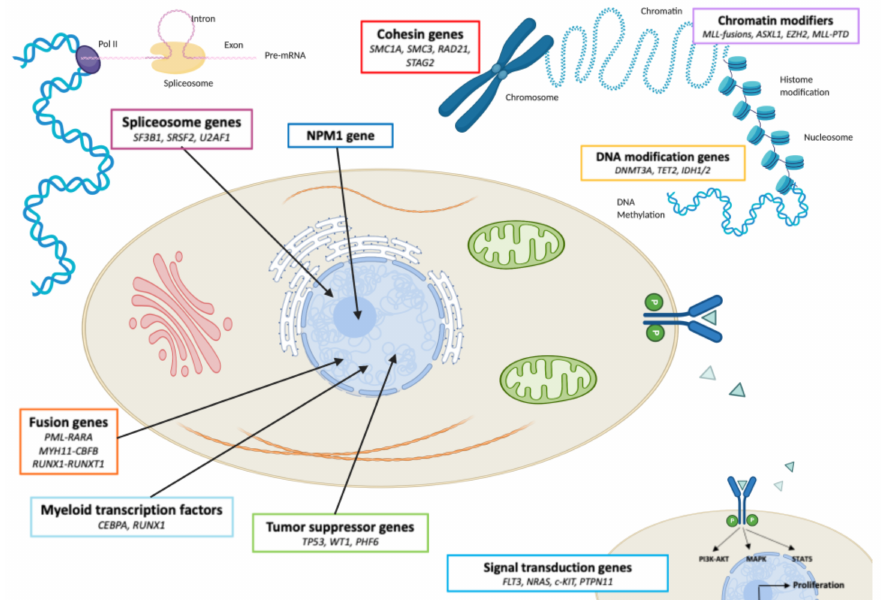
Figure 2. Functional categories of AML mutated genes. Genes mutated in AML are grouped based on their biological function. Gene categories are schematically depicted at the cellular